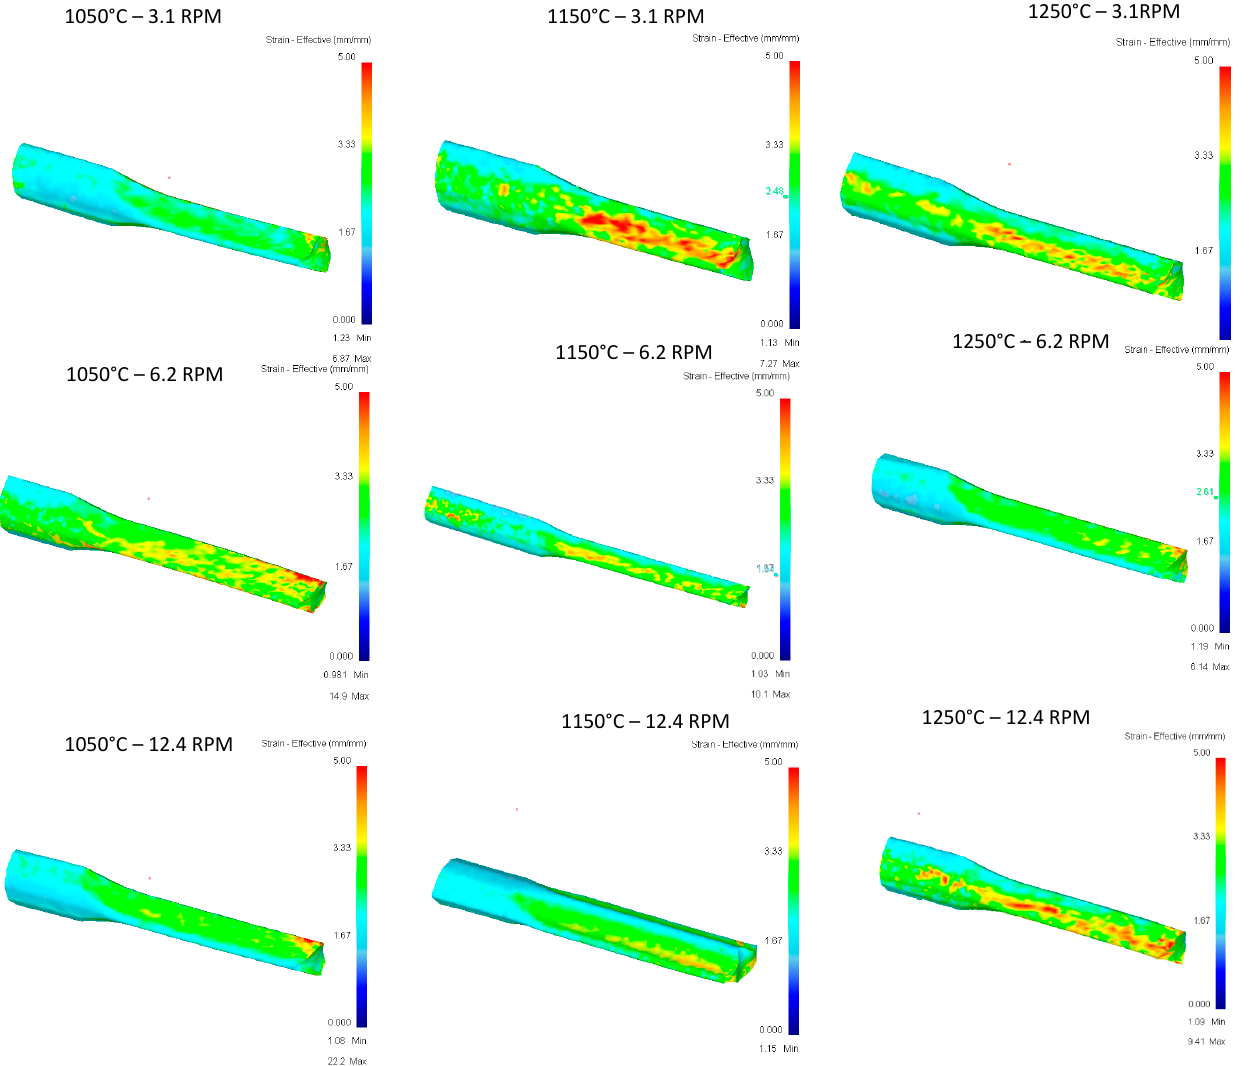
Figure 20. Effective Stress in the top Rail after fourth pass. Figure 21 shows the temperature graph obtained for the fourth pass for all the dif- ferent scenarios of this work.